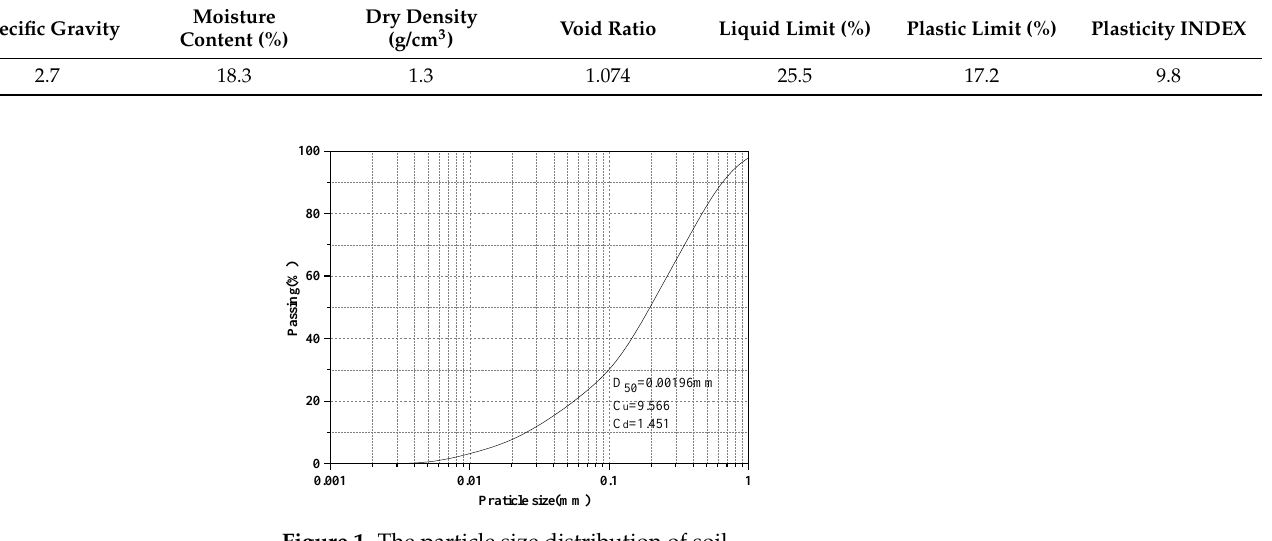
Figure 1. The particle size distribution of soil.